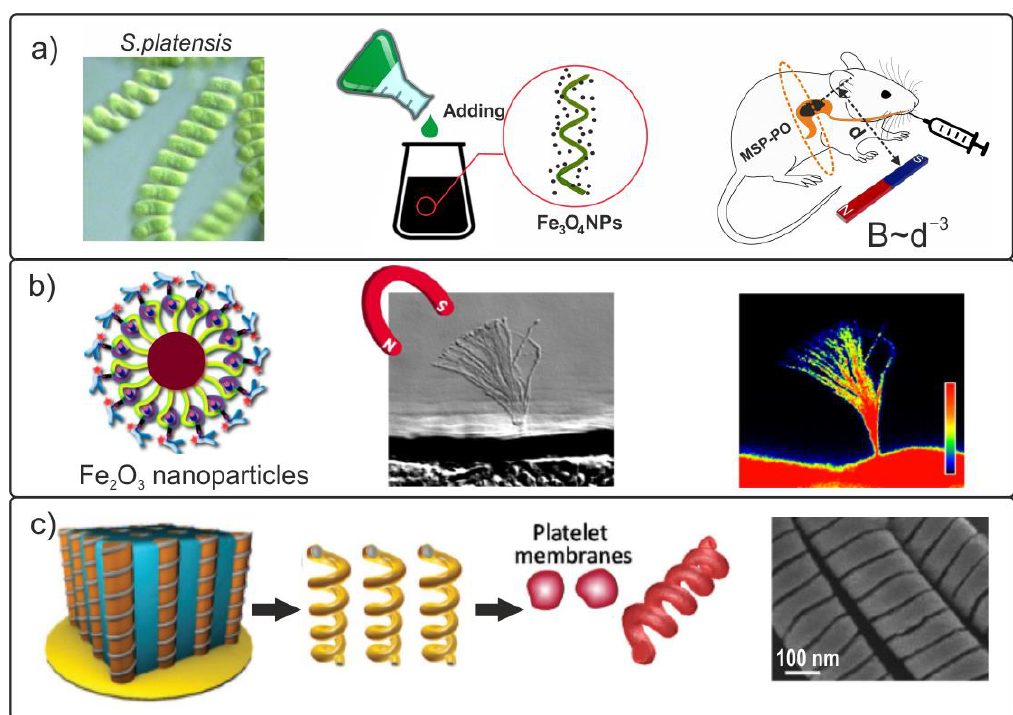
Figure 11. ( a ) Covering of S. platensis with magnetite and the MRI study of biohybrid microrobots inside a rodent. ( b ) Demonstration of Fe 3 O 4 -coated biohybrid magnetic cilia for treating the polycystic kidney disease [143]. Copyright 2019, American Chemical Society. ( c ) Manufacturing process of magnetic helical nanomotors coated with platelet membranes, and SEM photo of fabricated bare helical nanomotors [144].